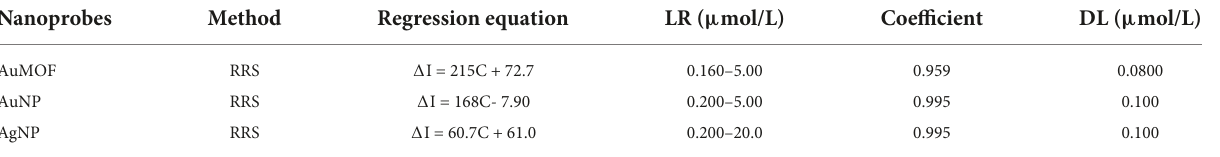
TABLE 1 Comparison of analytical properties of the three